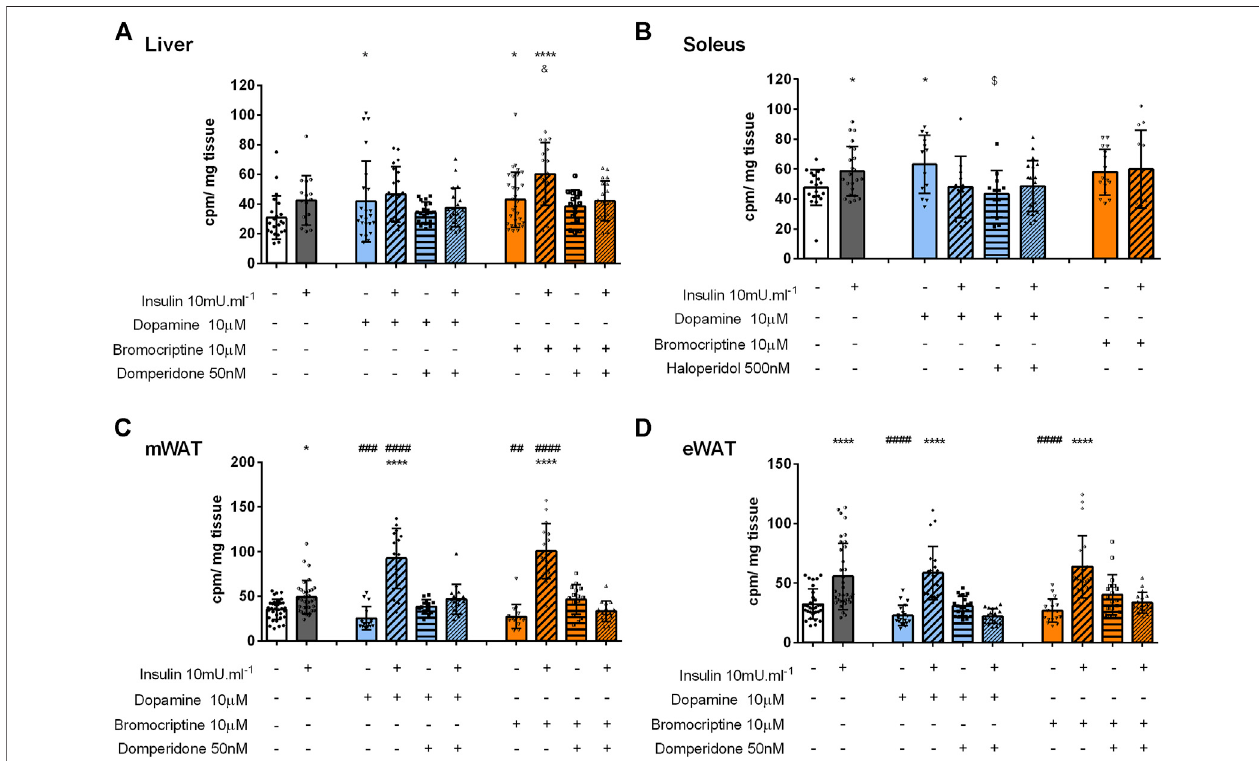
FIGURE 3 | Role of dopamine and bromocriptine on ex vivo glucose uptake in the liver (A) , soleus muscle (B) , mWAT (C), and eWAT (D) . The effect of dopamine (10 μ M,bluebars)andbromocriptine,aD2Ragonist(10 μ M,orangebars),on2-deoxy-D-[1,2 – 3H]-glucoseuptakeinthepresenceandabsenceofinsulin(10m U ml-1) and its blockade by domperidone, a D2R antagonist (50 nM) and/or haloperidol (500 nM) a D1R and D2R antagonist in the liver, the soleus muscle, mWAT, and eWAT. Bars represent means ± SD. One-way ANOVA with Dunnet ’ s post hoc comparison test * vs. control; # vs. insulin; $ vs. dopamine, & vs. bromocriptine. Levels of signi fi cance: * p < 0.05; ** p < 0.01; *** p < 0.001; **** p < 0.0001. mWAT, mesenteric white adipose tissue; eWAT, epididymal white adipose tissue; D1R, dopamine receptor 1; and D2R, dopamine receptor type